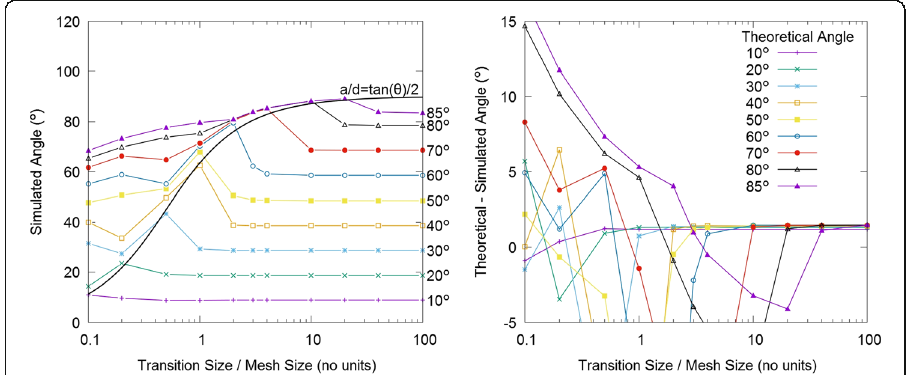
Fig. 10 Left : plot of contact angles calculated via the gradient method as a function of the mesh density and theoretical sharp interface contact angles for a transition size of 0.1 μ m. Right : difference between the theoretical and simulated contact angles from the figure to the left